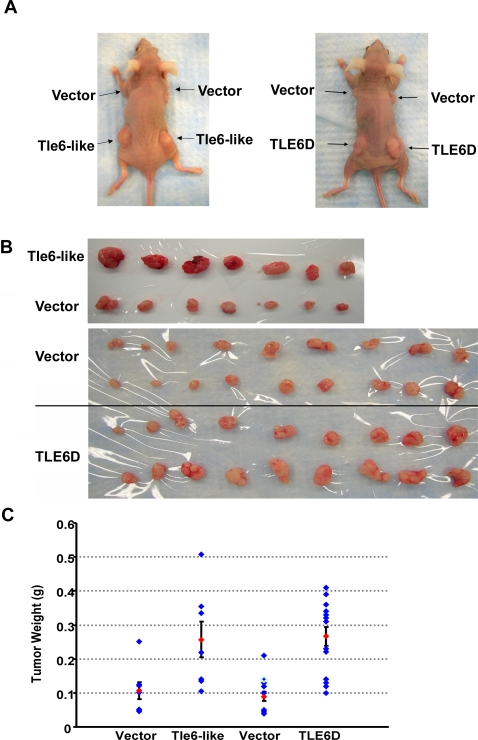
Tle6-like and TLE6D Enhance Gastrointestinal Tumor Progression.(A) Left panel, Xenograft of HCT116 cell lines expression Tle6-like or vector alone. Right Panel, Xenograft of HCT116 cell lines expression TLE6D or vector alone. (B) Representative xenograft tumors of HCT116 cells expressing pCS2+MT -Tle6-like, pCS2+MT vector, pcDNA6/HisA-TLE6D and empty pcDNA6/HisA vector. (C) Tumor weight in HCT116 xenograft tumors expressing Tle6-like or empty pCS2+MT vector and TLE6D and empty pcDNA6/HisA vector (Error bars indicate the standard deviation of the mean; p Value<0.005).